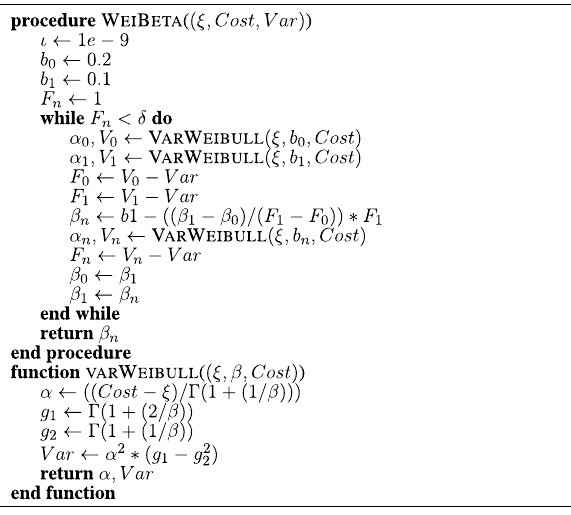
Algorithm 1. Procedure for the estimation of the Weibull distribution